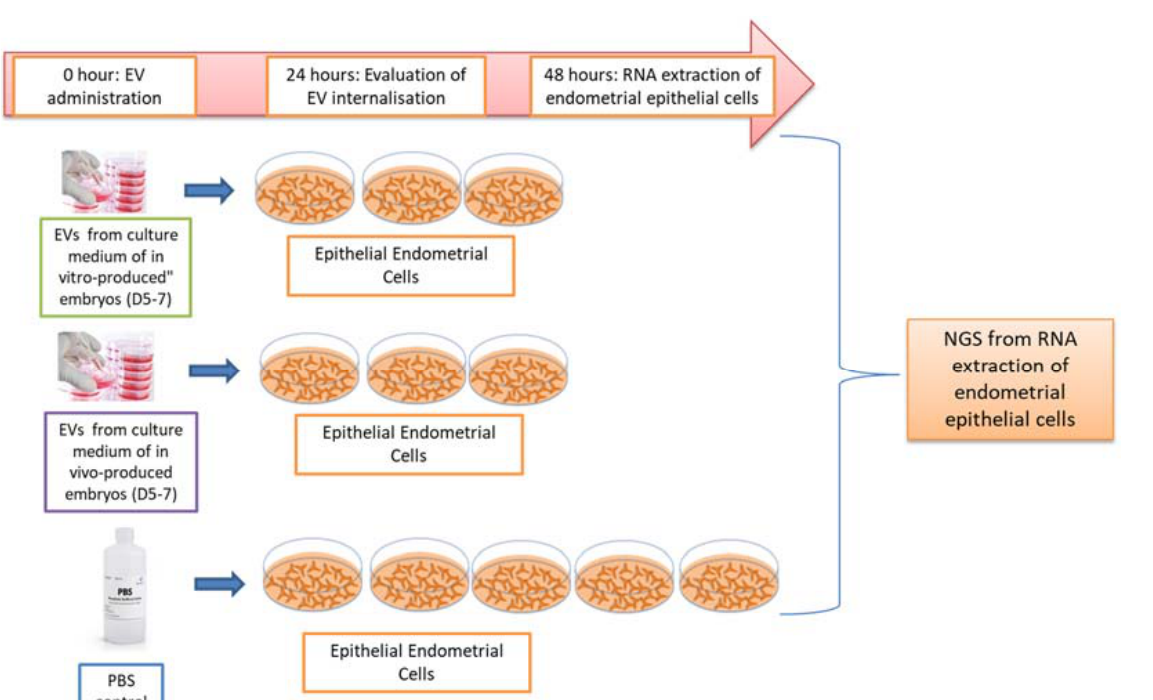
Figure 8. Illustration of experimental design. Extracellular vesicles (EVs) were isolated from a culture media of in vitro (IVP)- or in vivo (IVV)-derived bovine embryos. Morulae were selected on Day 5 of development and cultured individually until Day 7. Culture media were collected from embryos that developed to blastocyst stage. Isolated EVs were stained with PKH67 and added to in vitro-cultured bovine endometrial cells to assess EV internalization 24 h later. Cells were harvested 48 h after the addition of EVs for gene expression analysis. Cells treated with PBS were used as a negative